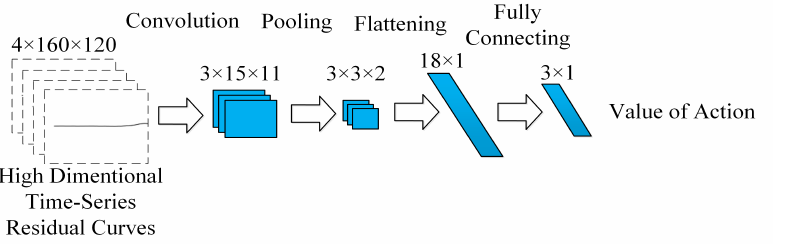
Figure 3. Structure of Q network in the DDQN of each agent, where blue blocks represent convolu- tional or fully connecting